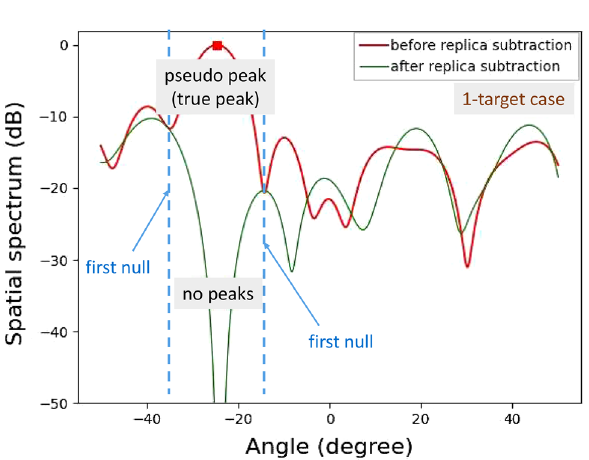
Figure 18. Experimental results for vertical angle estimations in a single-target case (20 m away).